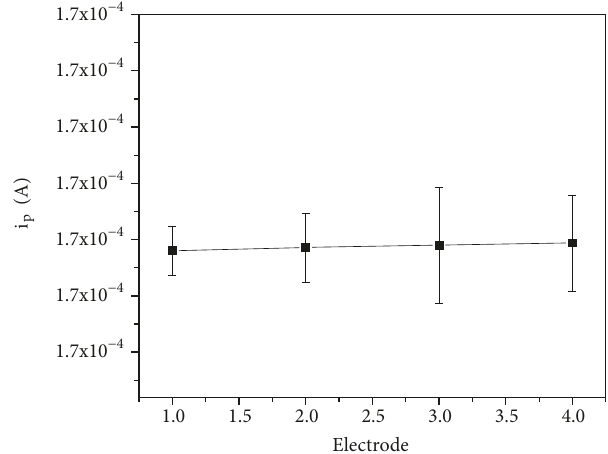
Figure 6: Electrode to electrode reproducibility of SPCE in 1 mM UA solution in 0.1 M PBS (pH 7) solution at scan rate of 10 mV/s, pulse amplitude of 240 mV, and pulse period of 100